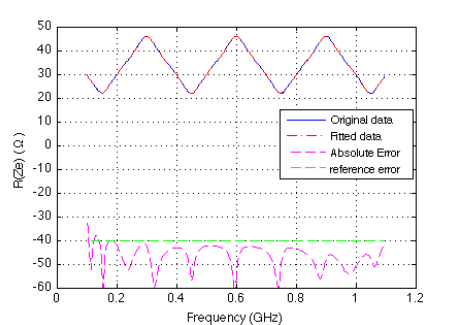
Figure 4. Impedance seen from the input of the line for a -40 dB error constraint.